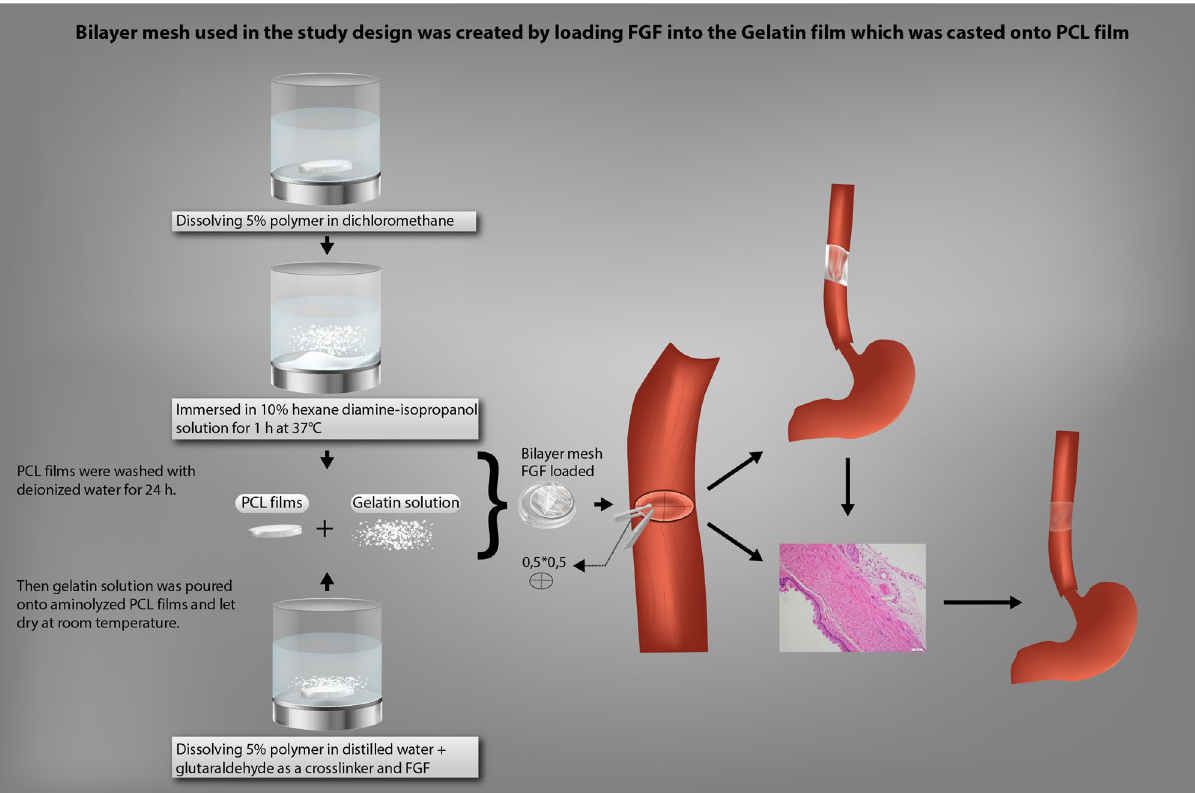
Figure 5. Bilayer mesh used in the study design was created by loading FGF into the Gelatin film which was casted onto PCL film showing preparation of bilayer meshes; PCL films were prepared by dissolving 5% polymer in dichloromethane. Dried PCL films were immersed in 10% hexane diamine-isopropanol solution for 1 h at 37 °C for aminolization. PCL films were washed with deionized water for 24 h. Gelatin solution was